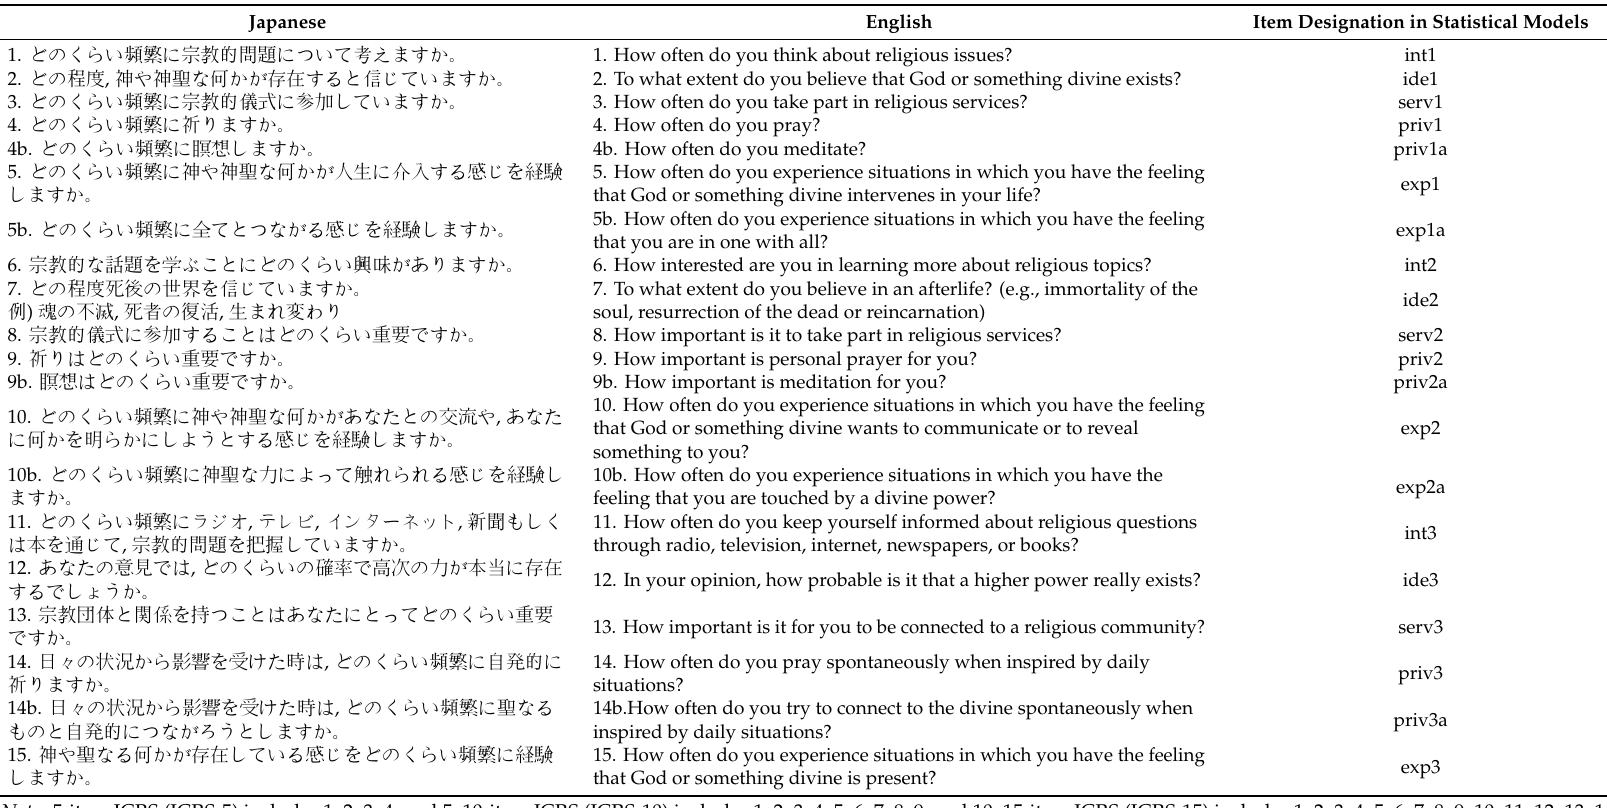
Table A1. Japanese version of the Centrality of Religiosity Scale (JCRS) translated from the English version of the Centrality of Religiosity Scale (Huber and Huber